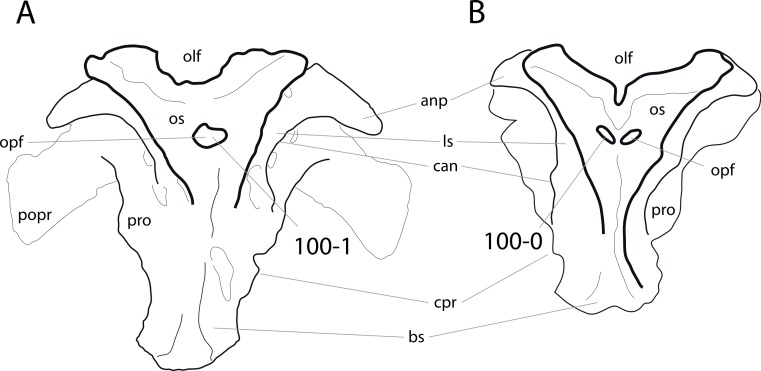
Flagellicaudatan braincases.Braincases of Suuwassea emilieae ANS 21122 (A), and Tornieria africana MB.R.2386 (B; traced from Janensch, 1935) in anterior view. Note the unpaired optic foramen of Suuwassea (A; C100-1), in contrast to the paired foramen in Tornieria (B; C100-0). Abb.: anp, antotic process; bs, basisphenoid; can, crista antotica; cpr, crista prootica; ls, laterosphenoid; olf, olfactory foramen; opf, optic foramen; os, orbitosphenoid; popr, paroccipital process; pro, prootic. Scaled to the same width of the orbitosphenoids.